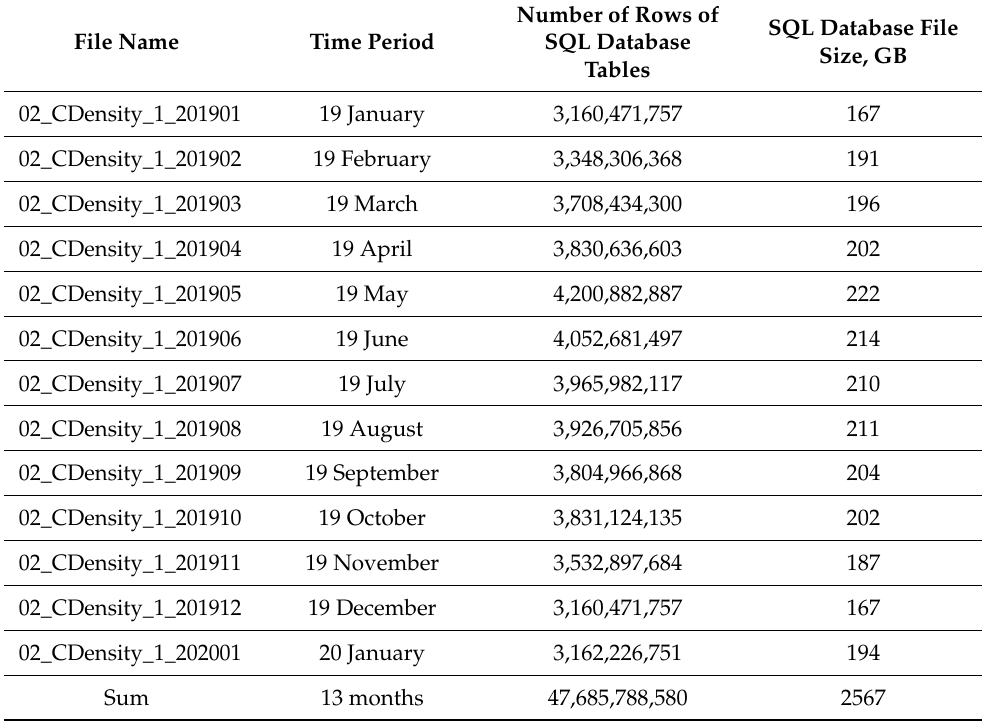
Table 2. Characteristics of the primary mobile operator’s database for Moscow region of Russia.